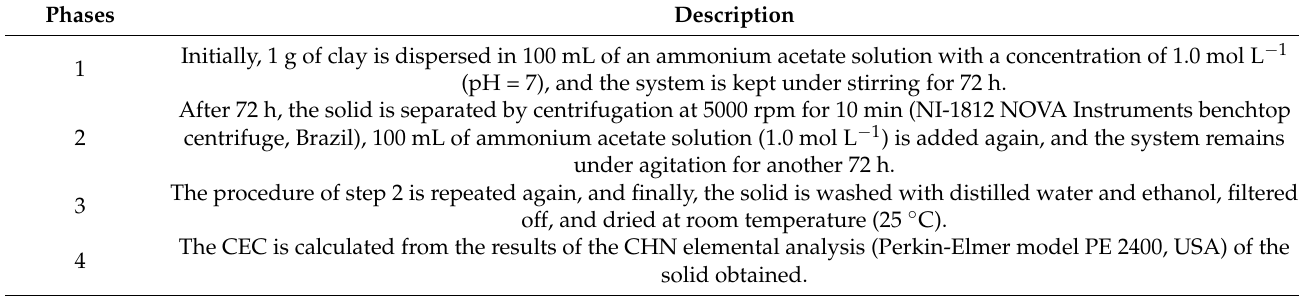
Table 3. Cation exchange capacity (CEC) of Bent by the ammonium acetate method.